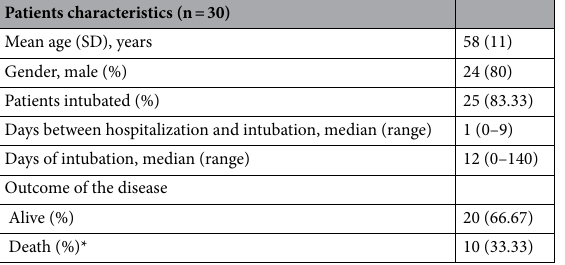
Table 1. Demographics and clinical characteristics of the study cohort. SD = standard deviation; range is expressed as minimum value–maximum value. *All patients died in ICU (< 35 days following onset of symptoms).